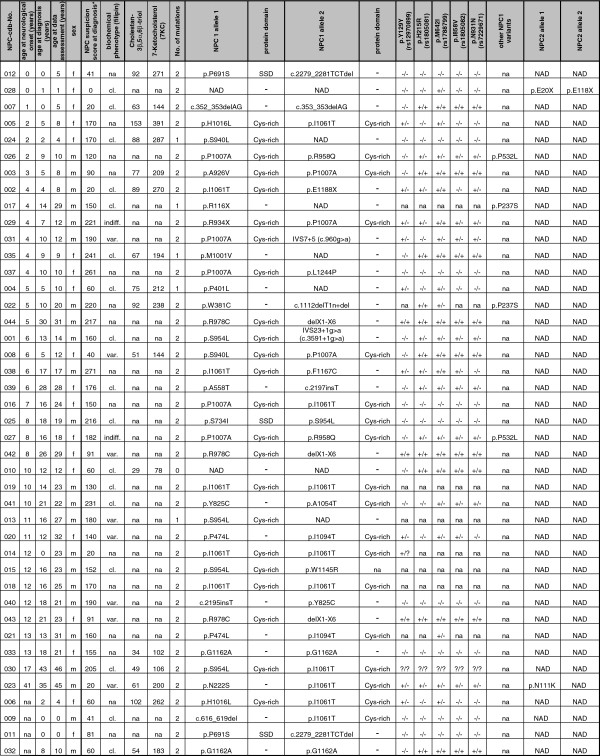
Diagnostic findings in studied NP-C patient cohort (n=42).* NP-C Suspicion Index (acc. to Wijburg et al., 2012): <40, NP-C unlikely; 40-69, NP-C follow up advised; ≥70, NP-C likely; na, not available; NAD, nothing abnormal detected; cl., classic; var., variant; indiff., indifferent; Cys-rich, cystein-rich loop (aa 855-1098); SSD, sterol sensing domain (aa 615-797), normal range: 3β,5α,6β-triol: 29-152; 7-KC: 78-390.